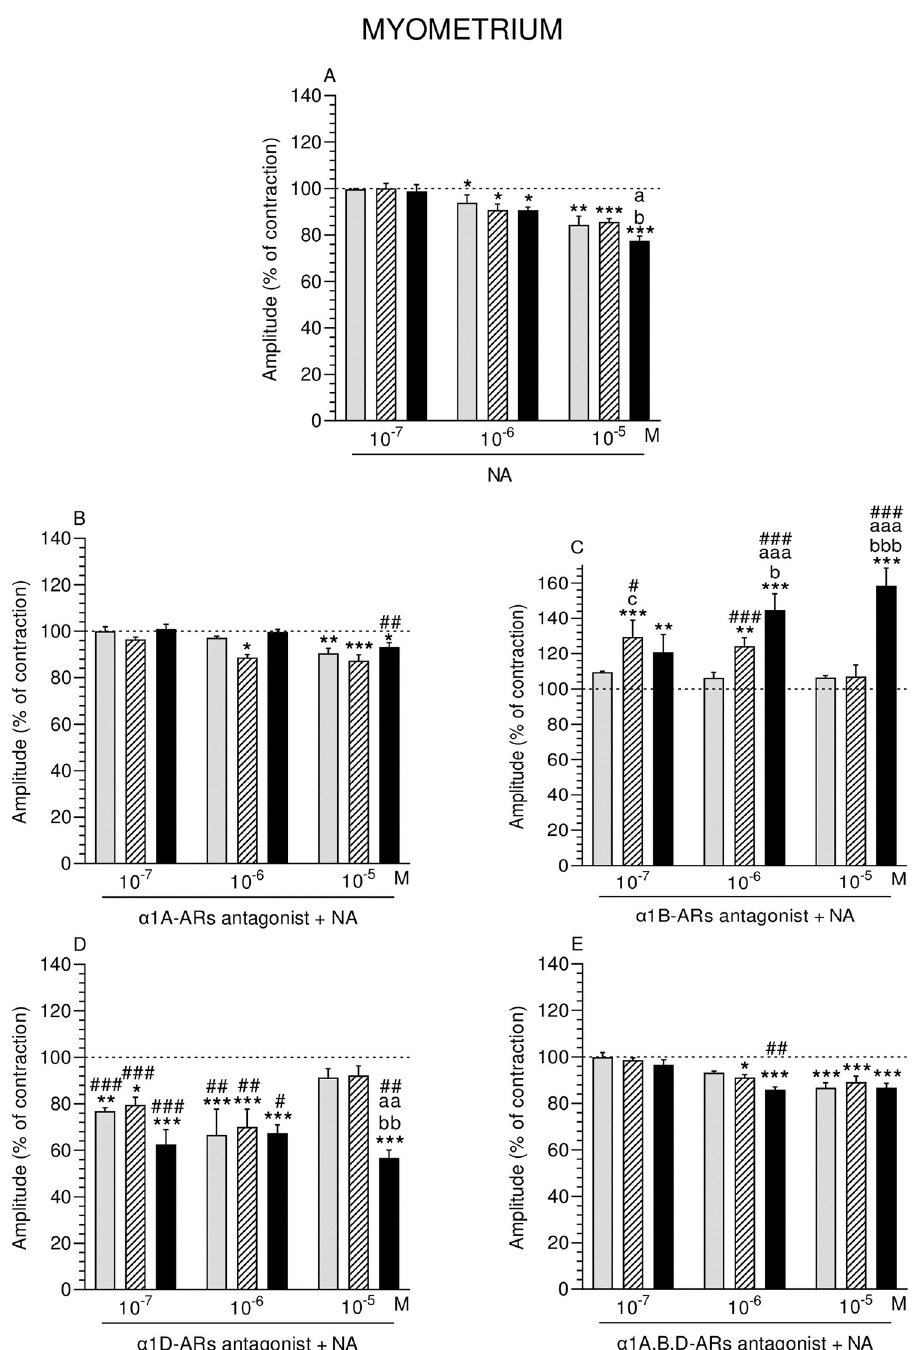
Fig 4. Effect of noradrenaline (NA) alone (A) and NA with α 1A- (B), α 1B- (C), α 1D- (D) and α 1A,B,D (E)– adrenoreceptors (ARs) antagonists (a dose of 10 − 4 M) on the amplitude of contractions in pig myometrium strips obtained from the CON (grey bars), SAL (hatched bars), and E . coli (black bars) groups. Data from five experiments (gilts, in each group). Effects of particular doses of NA and antagonists are expressed as percentage (mean ± SEM) in relation to the basal (pre-treatment period) contractile amplitude, established as 100% (horizontal lines). � P < 0.05, �� P < 0.01, ��� P < 0.001—indicate differences from baseline in each group; a P < 0.05, aa P < 0.01, aaa P < 0.001- indicate differences between CON and E . coli groups for the same treatment; b P < 0.05, bb P < 0.01, bbb P < 0.001—indicate differences between SAL and E . coli groups for the same treatment; # P < 0.05, ## P < 0.01, ### P < 0.001 compared between particular antagonist with NA effect versus NA effect alone for the same group/NA dose.